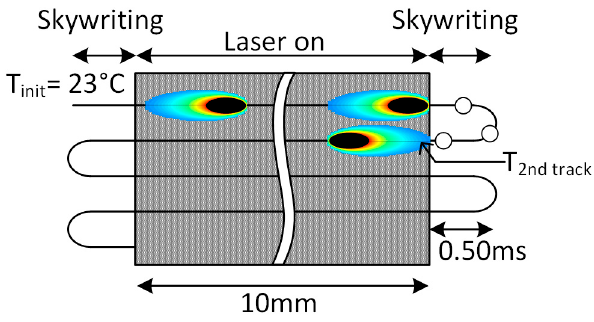
Figure 13. Schematic representation of the laser journey.